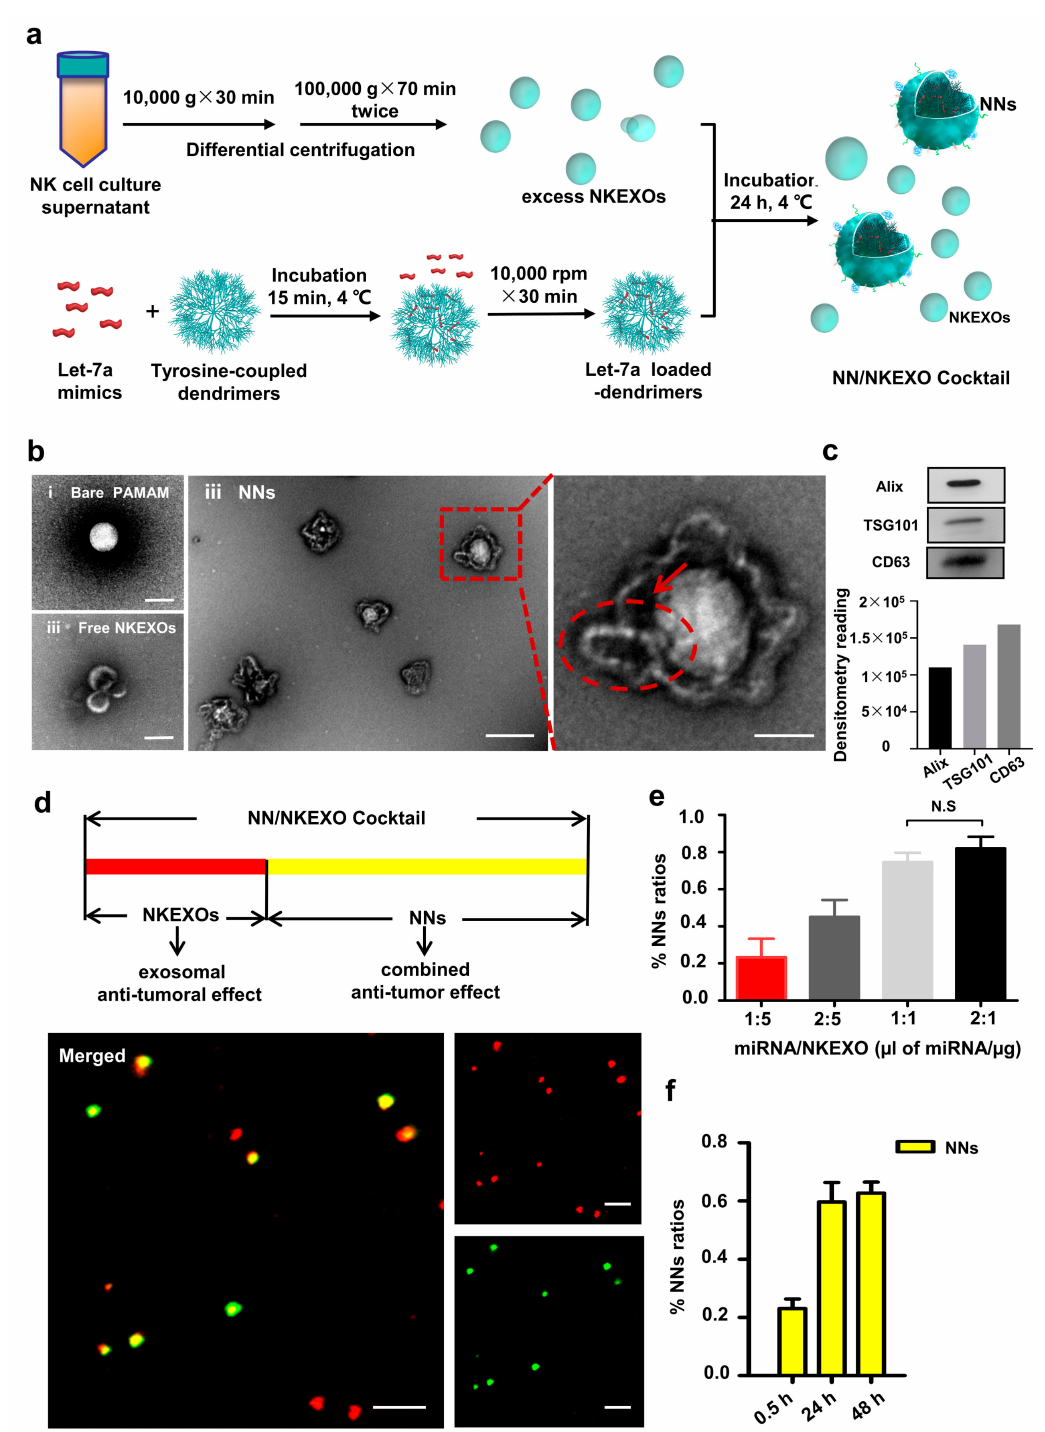
Figure 2. Fabrication and characterization of the NN / NKEXO cocktail. ( a ) Schematic design of the NN / NKEXO cocktail. ( b ) TEM images of bare PAMAM dendrimers (i), NNs (ii) and free NKEXO in supernatant (iii). The arrow indicates an integrated NKEXO. ( c ) NNs contain typical intracellular proteins markers (ALIX, TSG101), confirmed by Western blot (WB). ( d ) CLSM images of the fabricated NN / NKEXOcocktailillustratingthecolocalizationoflet-7aloadeddendrimers(green)andNKEXO(red). ( e ) Percentages of NNs in the NN / NKEXO cocktail at di ff erent miRNA to NKEXO ratios. ( f ) Percentages of NNs in NNs-NKEXO cocktail at di ff erent synthesis times at a 1:1 miRNA to NKEXO